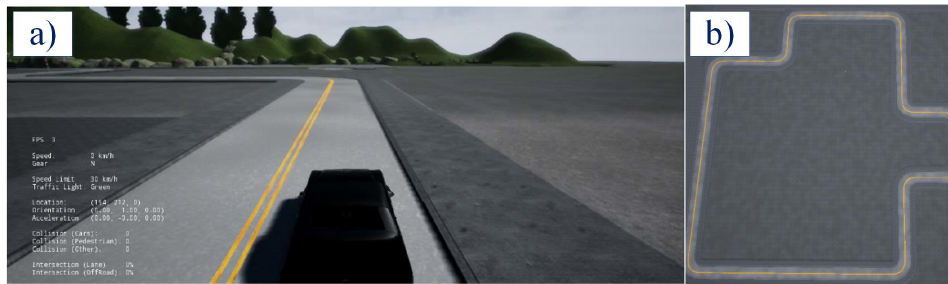
Figure 2. ( a ) CARLA simulator environment; and ( b ) a top–down view of the